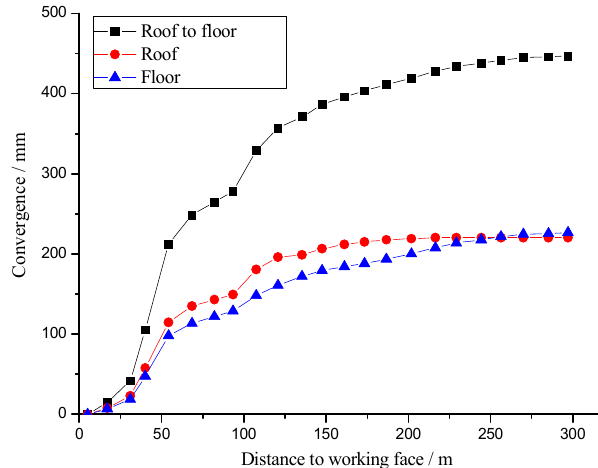
Figure 17. Vertical convergence of GERRC.